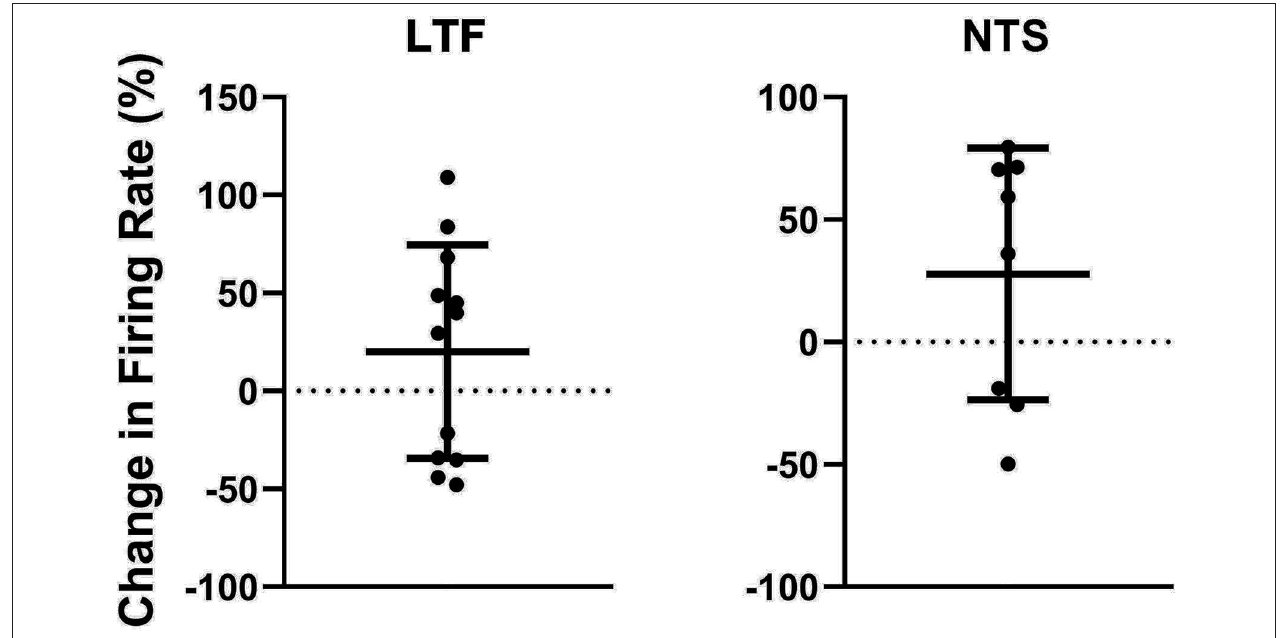
FIGURE 6 | Percent change in firing rate when the animal was tilted nose-up (firing rate in nose-up position ÷ firing rate in the nose-down position) for the 12 units in the LTF and 8 units in the NTS with CRA whose activity was significantly modulated during 40 ◦ head-up tilts. Error bars indicate mean ± one standard deviation.